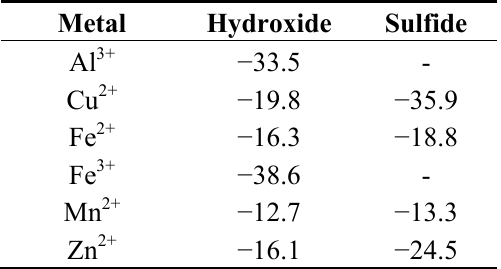
Table 1. Solubility products (log K values at 25 °C) of hydroxides and sulfides phases of sp metals typically found in acid mine drainage